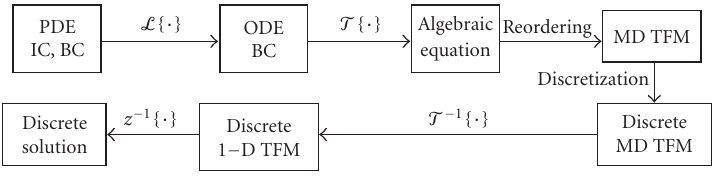
Figure 1: Procedure of the FTM solving initial boundary value problems defined in form of PDEs, IC, and BC.